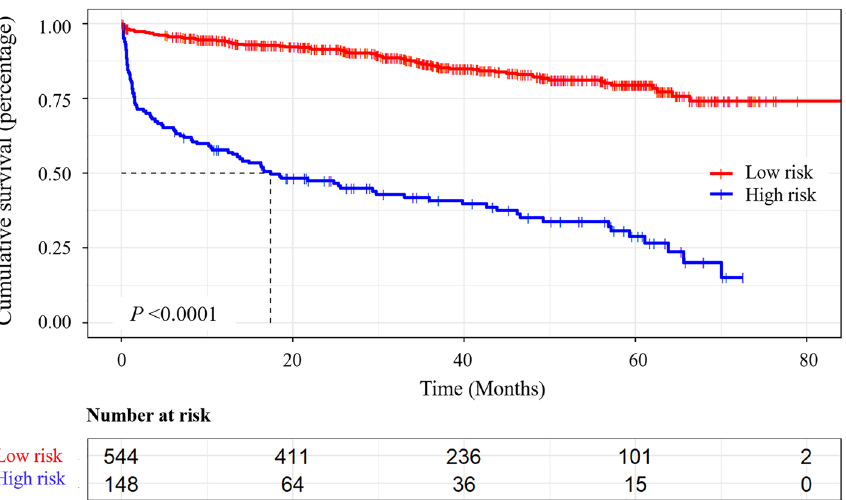
Figure 8. Kaplan–Meier curve of Risk stratification. Red line represents the survival curve of the low-risk group; Blue line represents the survival curve of the high-risk group; The dotted line refers to the median survival time in the high-risk group. Survival analysis was performed with Survival R package version 3.3–1 (Threneau 2022). Survival curves was generated with Survminer R package version 0.4.9 (Kassambara et al. 2021) and ggplot2 R library (Wickham